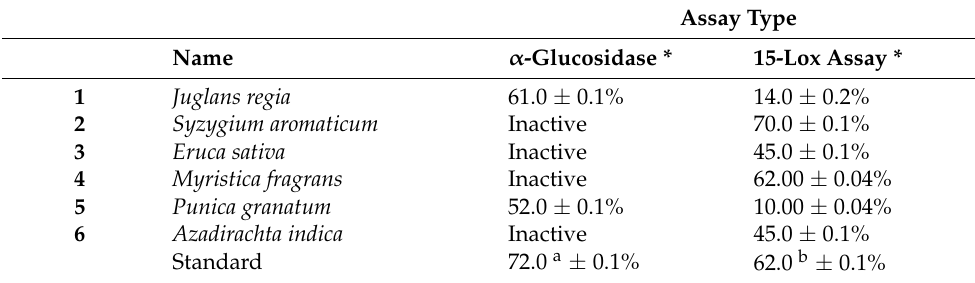
Table 4. α -Glucosidase and 15-Lipoxygenase assay of selected medicinal plants.